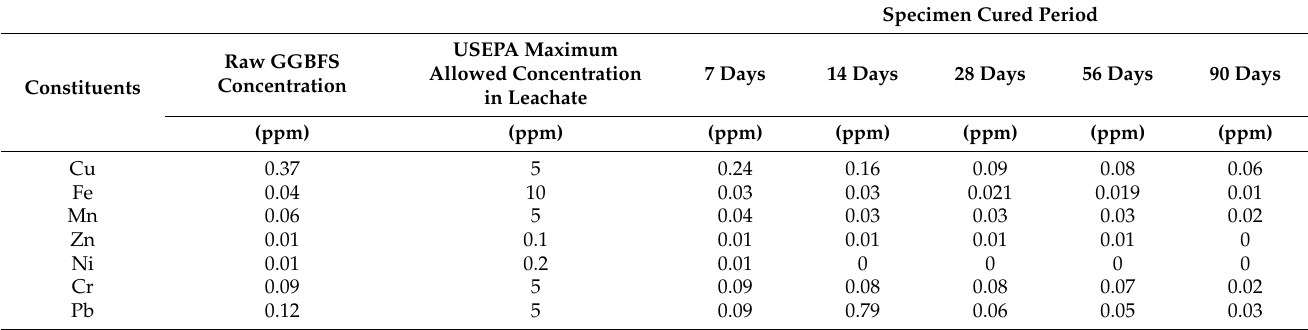
Table 5. Leachability of heavy metals concentration before and after alkaline